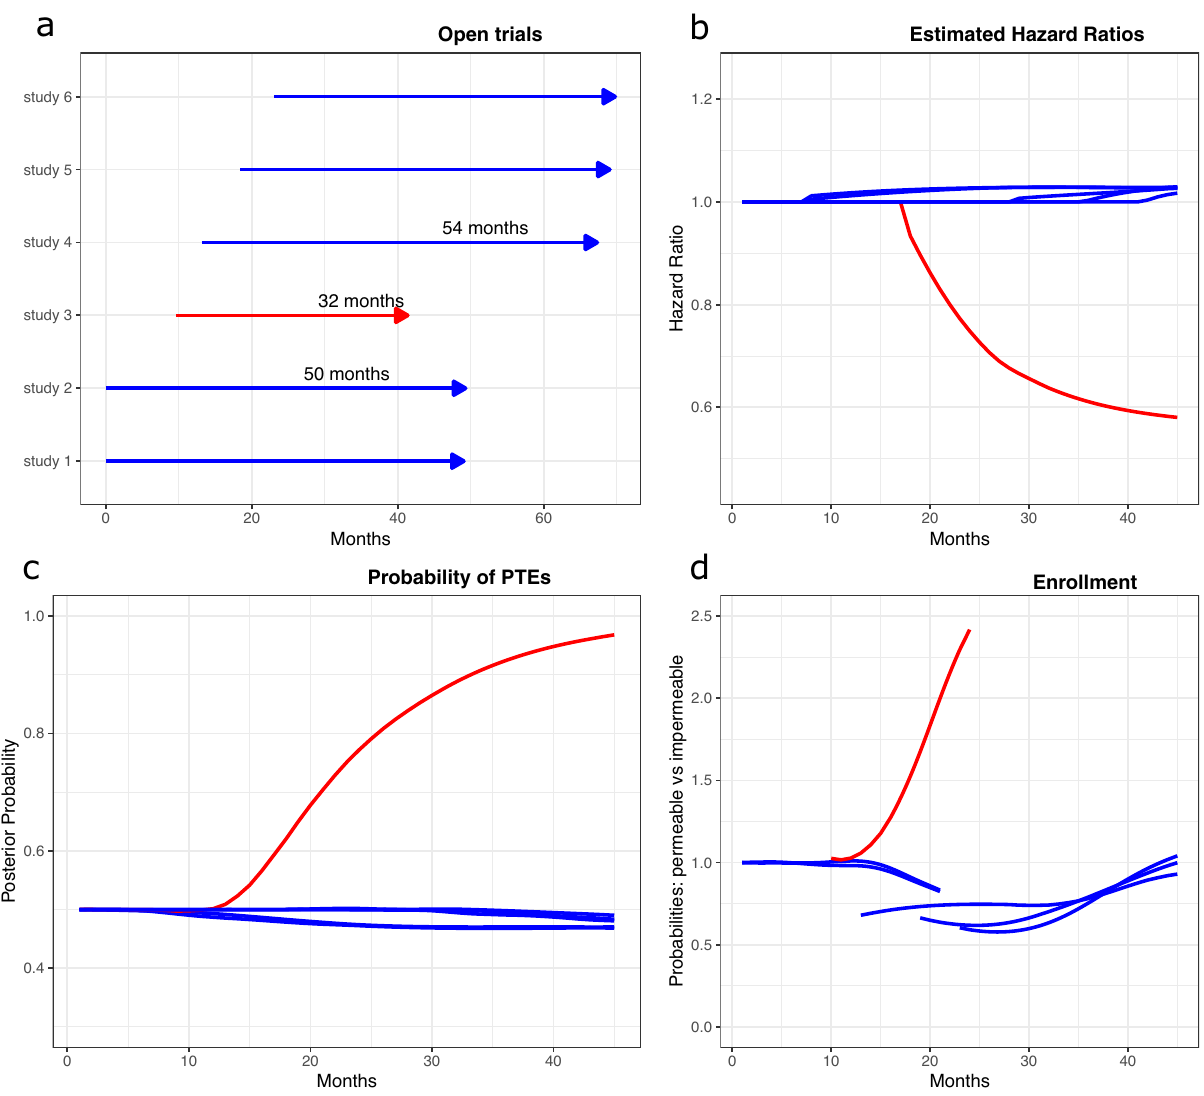
Fig. 1 Selected operating characteristics of the permeable environment. A simulation study starts with two open trials, then four additional two-arm controlled trials are opened after 10, 13, 18, and 22 months. The experimental arm in trial 3 (red line) improves median survival time. Experimental arms in the remaining fi ve trials (blue lines) are ineffective with survival distributions identical to the standard of care (SOC). Panel a shows the average trial duration across simulations. The remaining panels show for each study the b average hazard ratio estimates across simulations, c the average posterior probability of a positive treatment effect (PTE) in trial j = 1, … ,6, and d the ratio between average enrollment probabilities in permeable and impermeable environments during fi xed time windows. The red line in panels b – c indicates the 3th trial, wich in this simulation study is the only trial testing an effective experimental treatment. Results are based on 10,000 simulations of the six